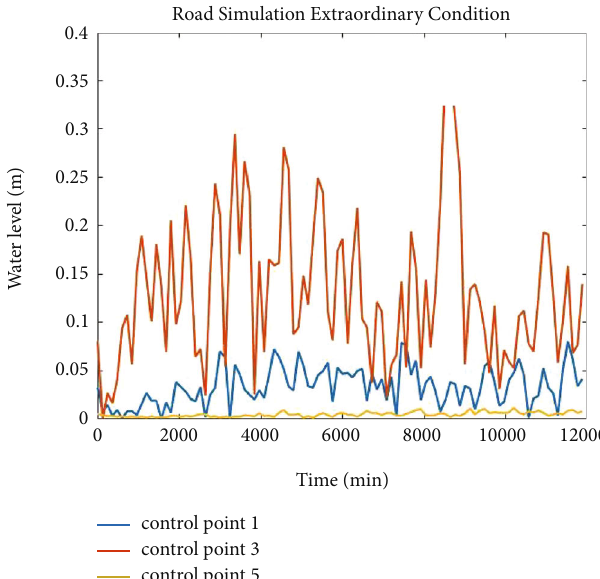
Figure 14: Fluctuation of the free-surface at the control point 1, 3, and 5 with road simulation extraordinary condition. Table 4: Maximum wave height referred to below average low-tide level for control points 1, 3, and 5. Stage